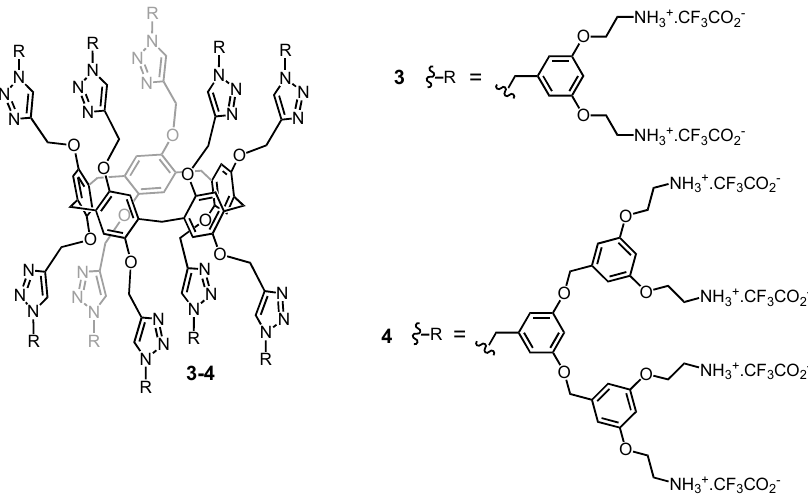
Figure 3. Dendronized pillar[5]arenes with peripheral ammonium functions (molecular weights (MW): 5787.41 ( 3 ); 11368.67 ( 4 )). These polycationic derivatives have been used as non-viral gene vectors.